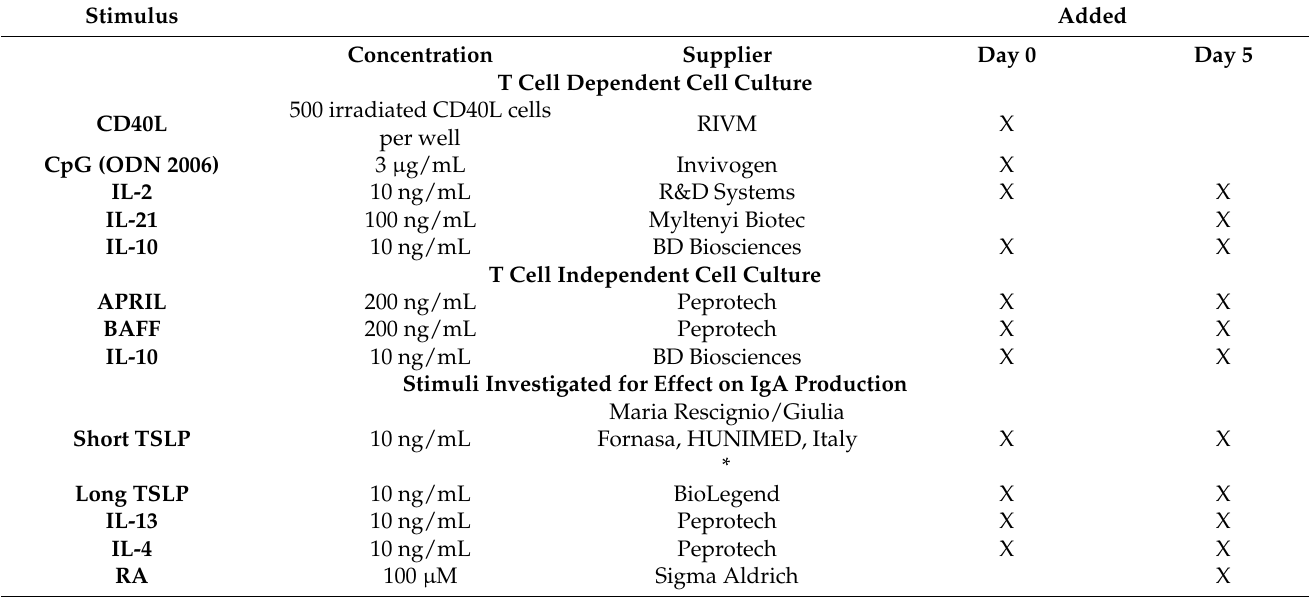
Table 1. Stimuli added at day 0 and 5 and used